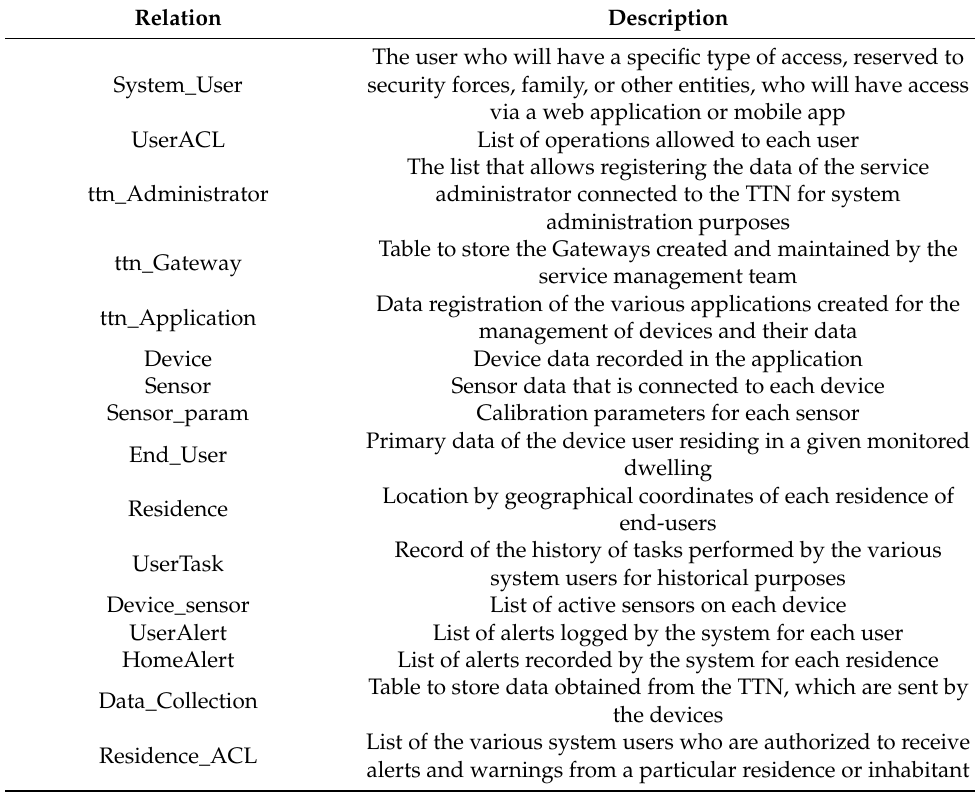
Table 1. Data model